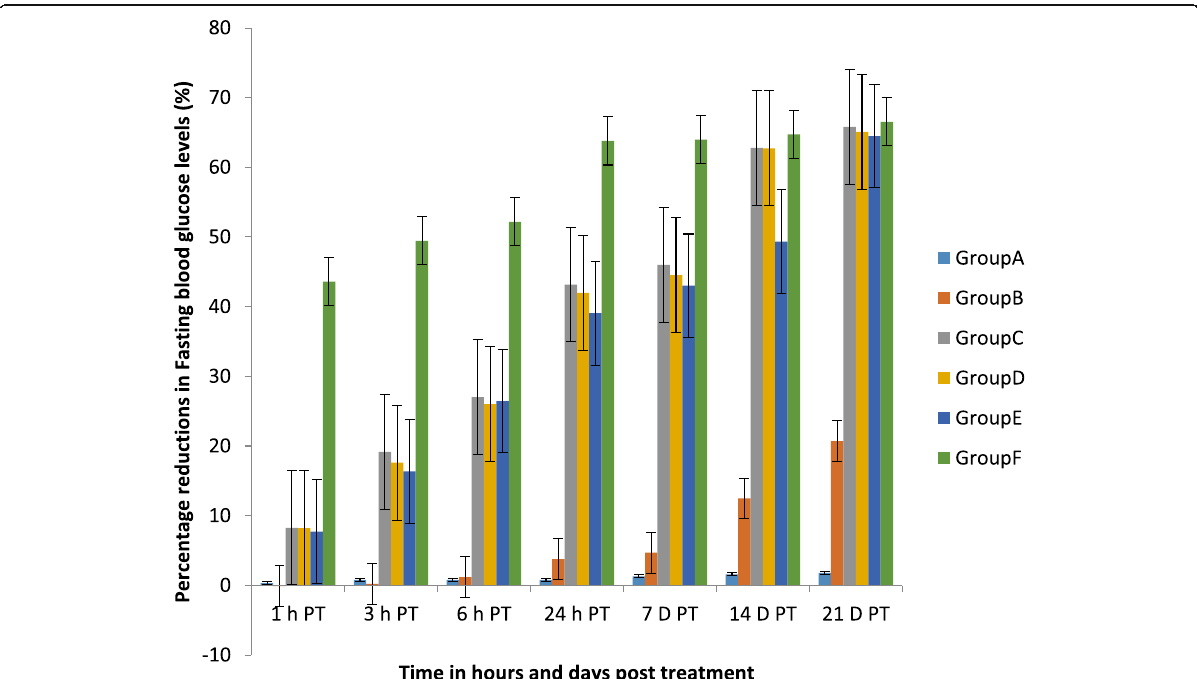
Fig. 1 Percentage reduction in FBG levels of alloxan-induced diabetic rats treated with aqueous leaf extract of V. amygdalina and B. tenoreana . PT Post-treatment, h hour (s), D Day